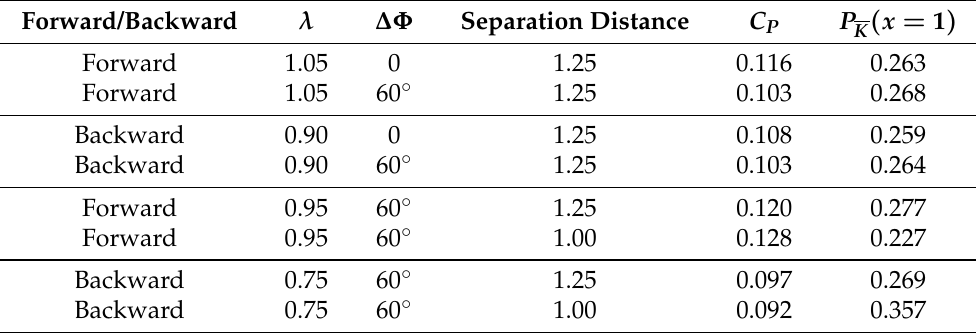
Table 1. Comparison of each configuration’s temporally and spatially averaged kinetic energy at x / D t = 1.0 and the associated power